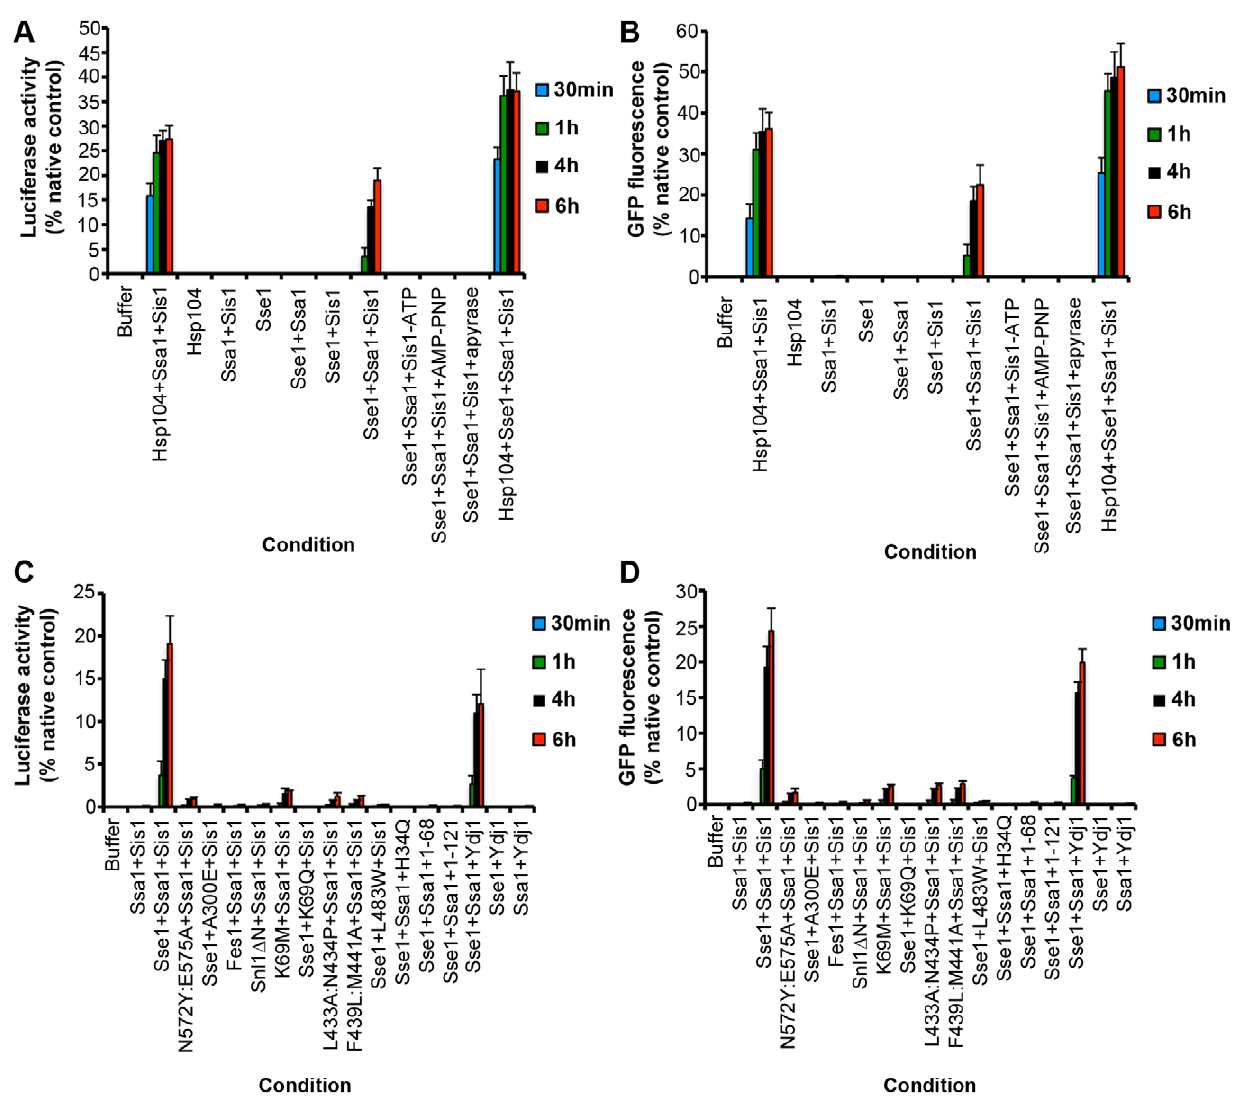
Figure 4. Hsp110 NEF activity, ATPase activity and substrate-binding activity are essential for protein disaggregation. ( A, B ) Urea- denatured luciferase aggregates (50 nM) (A) or heat-denatured GFP aggregates (0.45 m M) (B) were incubated for 30 min (blue bars), 1 h (green bars), 4 h (black bars), or 6 h (red bars) at 25 u C in buffer plus ATP (5 mM) and ATP-regeneration system without or with the indicated combination of Hsp104 (1 m M), Ssa1 (1 m M), Sis1 (1 m M) and Sse1 (1 m M). In the indicated reactions, ATP was either omitted or replaced with AMP-PNP. Alternatively, ATP was included but the ATP-regeneration system was replaced with apyrase. Disaggregation and reactivation of luciferase was monitored by luminescence. Luminescence measurements were converted into reactivation yield (% of the maximum recoverable luciferase activity) by comparison to the luminescence of known quantities of soluble, native luciferase ( A ). Disaggregation and reactivation of GFP was monitored by fluorescence. Fluorescence measurements were converted into reactivation yield (% of the maximum recoverable GFP fluorescence) by comparison to the fluorescence of known quantities of soluble, native GFP (B). Values represent means 6 SEM (n=3). ( C, D ) Urea-denatured luciferase aggregates (50 nM) ( C ) or heat-denatured GFP aggregates (0.45 m M) ( D ) were incubated for 30 min (blue bars), 1 h (green bars), 4 h (black bars), or 6 h (red bars) at 25 u C in buffer plus ATP (5 mM) and ATP-regeneration system without or with the indicated combination of Ssa1 (1 m M), Sis1 (1 m M), Sse1 (1 m M), Sse1 N572Y:E575A (1 m M, a NEF-defective Sse1 mutant), Ssa1 A300E (1 m M, an Ssa1 mutant unable to interact with Sse1), Fes1 (1 m M, a Ssa1 NEF), Snl1 D N (1 m M, a Ssa1 NEF), Sse1 K69M (1 m M, an ATPase-dead Sse1 mutant), Ssa1 K69Q (1 m M, an ATPase-dead Ssa1 mutant), Sse1 L433A:N434P (1 m M, a substrate- binding defective Sse1 mutant), Sse1 F439L:M441A (1 m M, a substrate-binding defective Sse1 mutant), Ssa1 L483W (1 m M, a substrate-binding defective Ssa1 mutant), Sis1 H34Q (1 m M, a Sis1 mutant unable to stimulate Ssa1 ATPase activity), Sis1 1–68 (1 m M, the J domain of Sis1), Sis1 1–121 (1 m M, the J and G/F-domains of Sis1) and Ydj1 (1 m M, an Hsp40). Disaggregation and reactivation of luciferase was monitored by luminescence. Luminescence measurements were converted into reactivation yield (% of the maximum recoverable luciferase activity) by comparison to the luminescence of known quantities of soluble, native luciferase (C). Disaggregation and reactivation of GFP was monitored by fluorescence. Fluorescence measurements were converted into reactivation yield (% of the maximum recoverable GFP fluorescence) by comparison to the fluorescence of known quantities of soluble, native GFP (D). Values represent means 6 SEM (n=3).